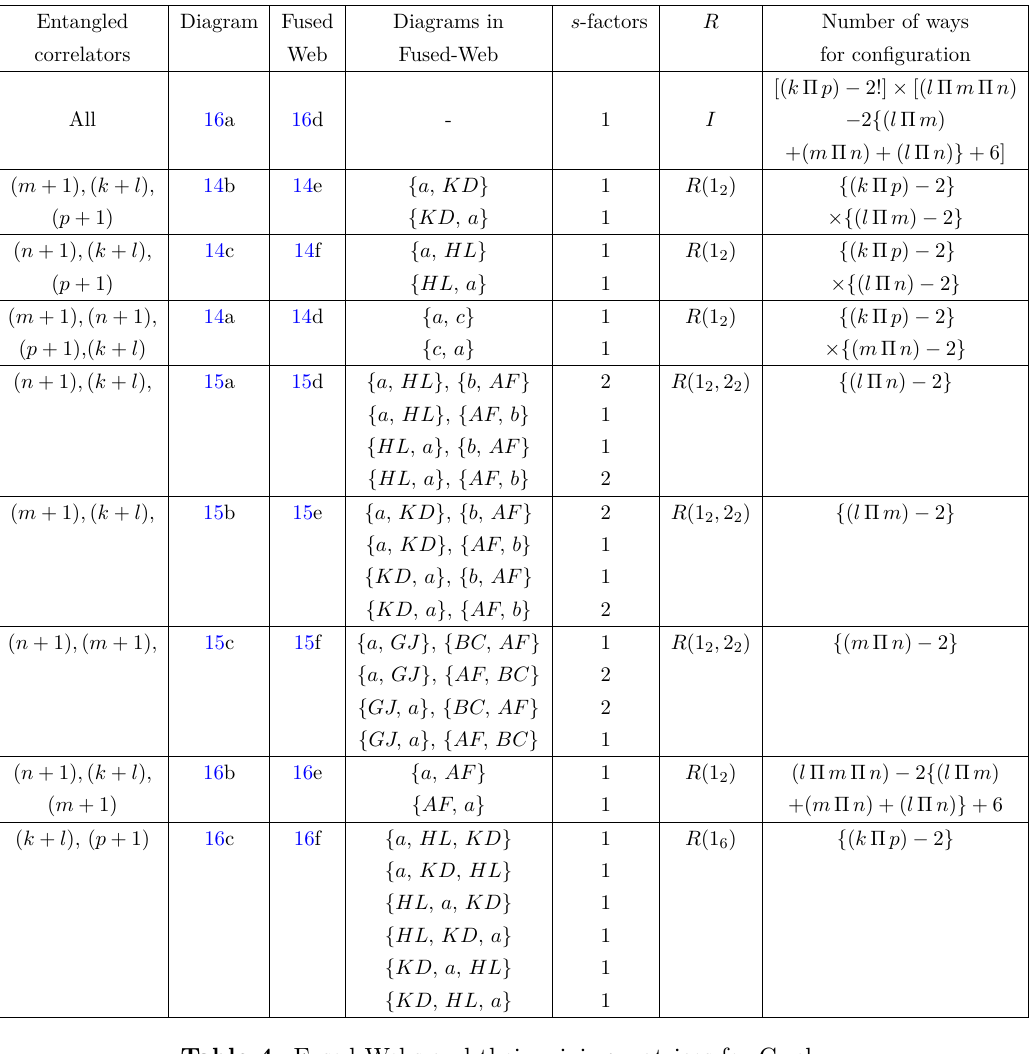
Table 4. Fused-Webs and their mixing matrices for